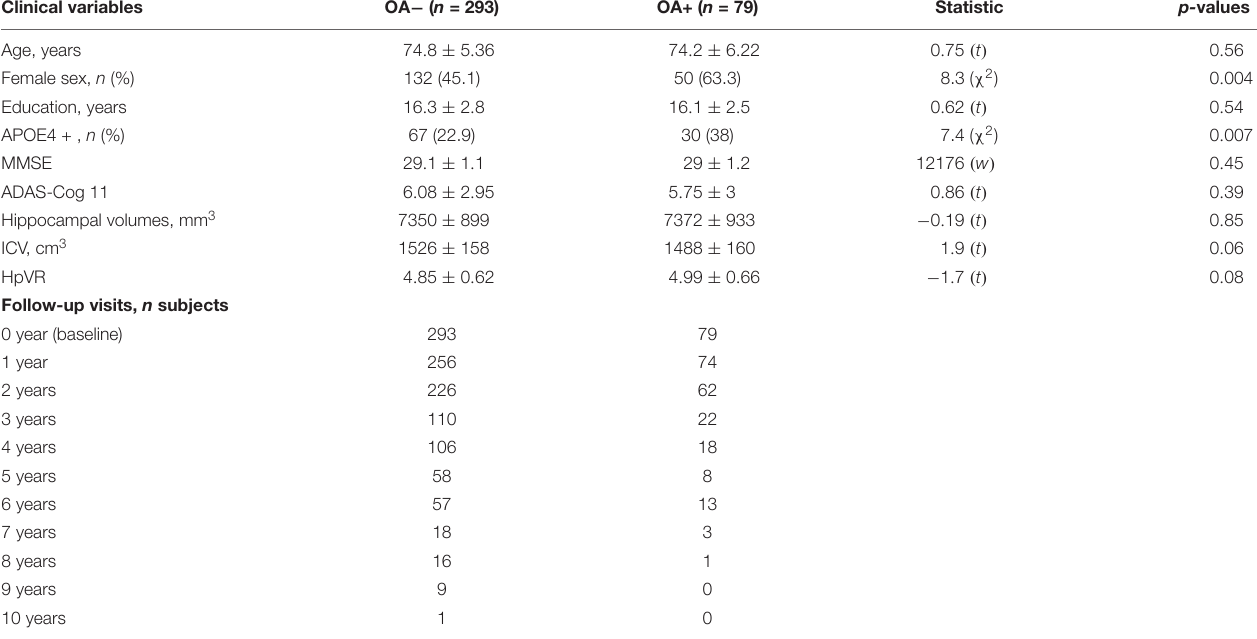
TABLE 1 | Demographics and clinical variables of the study participants.